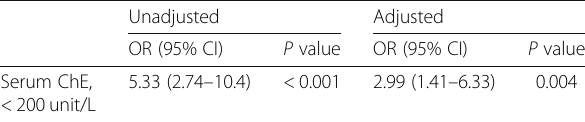
Table 3 Impact of low cholinesterase on predicting the development of complications after orthopedic surgery